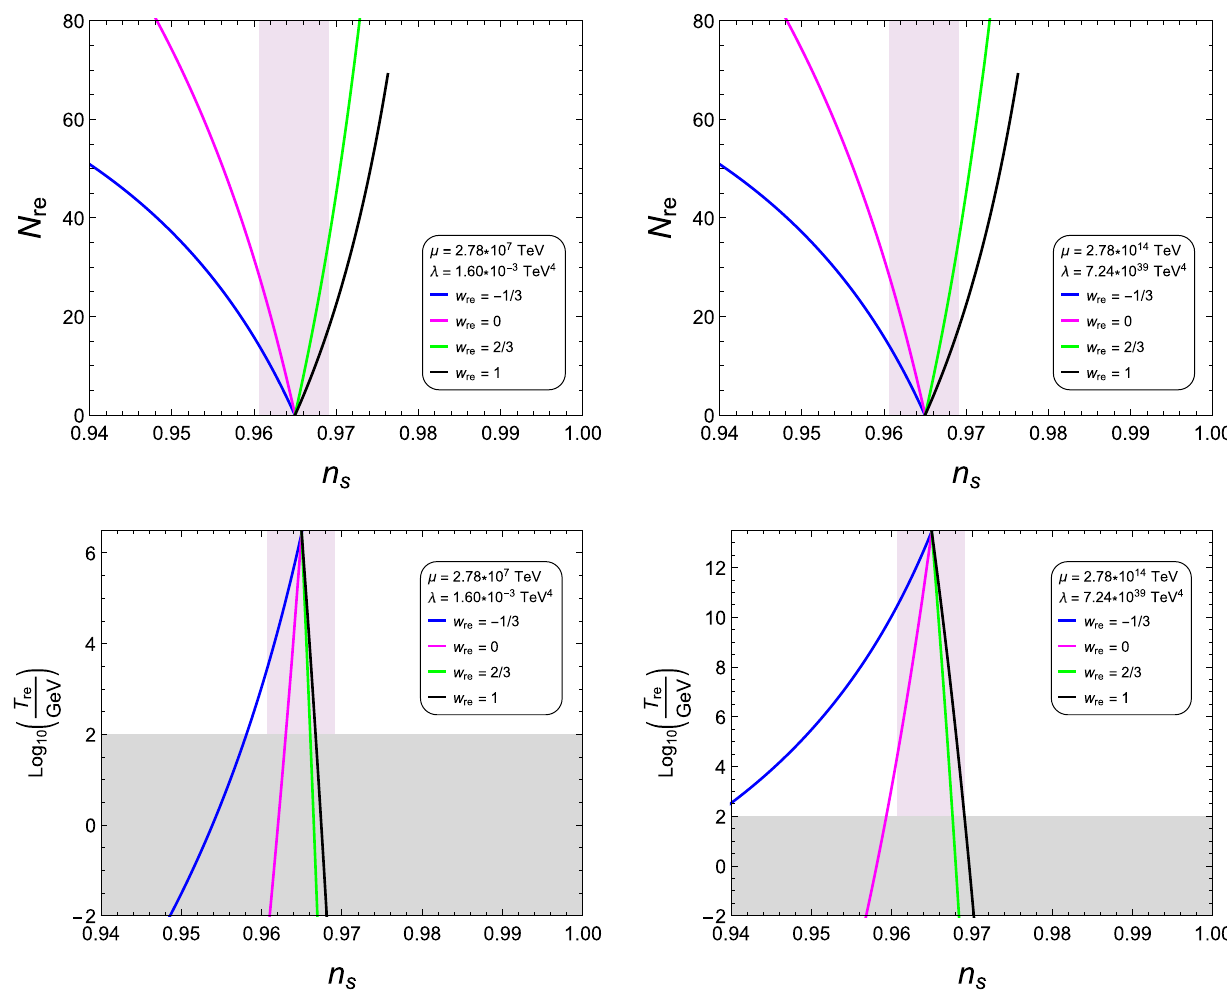
Fig. 7 Plots of N re and T re as functions of n s for Hilltop inflation. The left panels shows the plots for M 5 = 10 5 TeV while the right panels shows the plot for M 5 = 10 12 TeV. The curves and the shading regions are the same as Fig. 3 and all plots corresponds to α = 0 . 0135